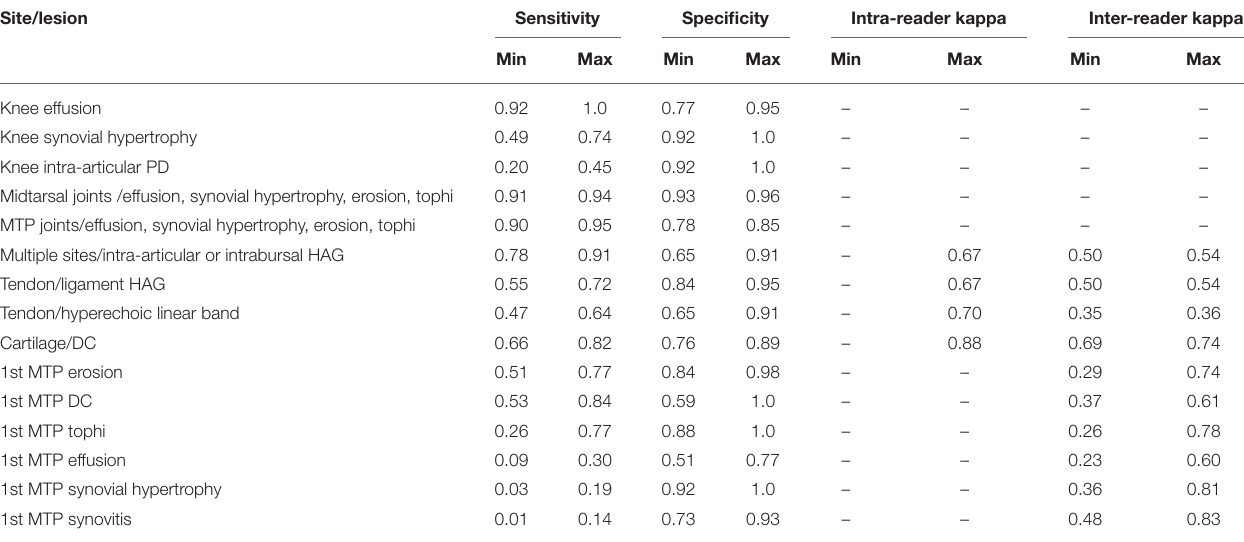
TABLE 10 | Performance of ultrasound to detect gout elementary lesions and reproducibility (intercritic phase).